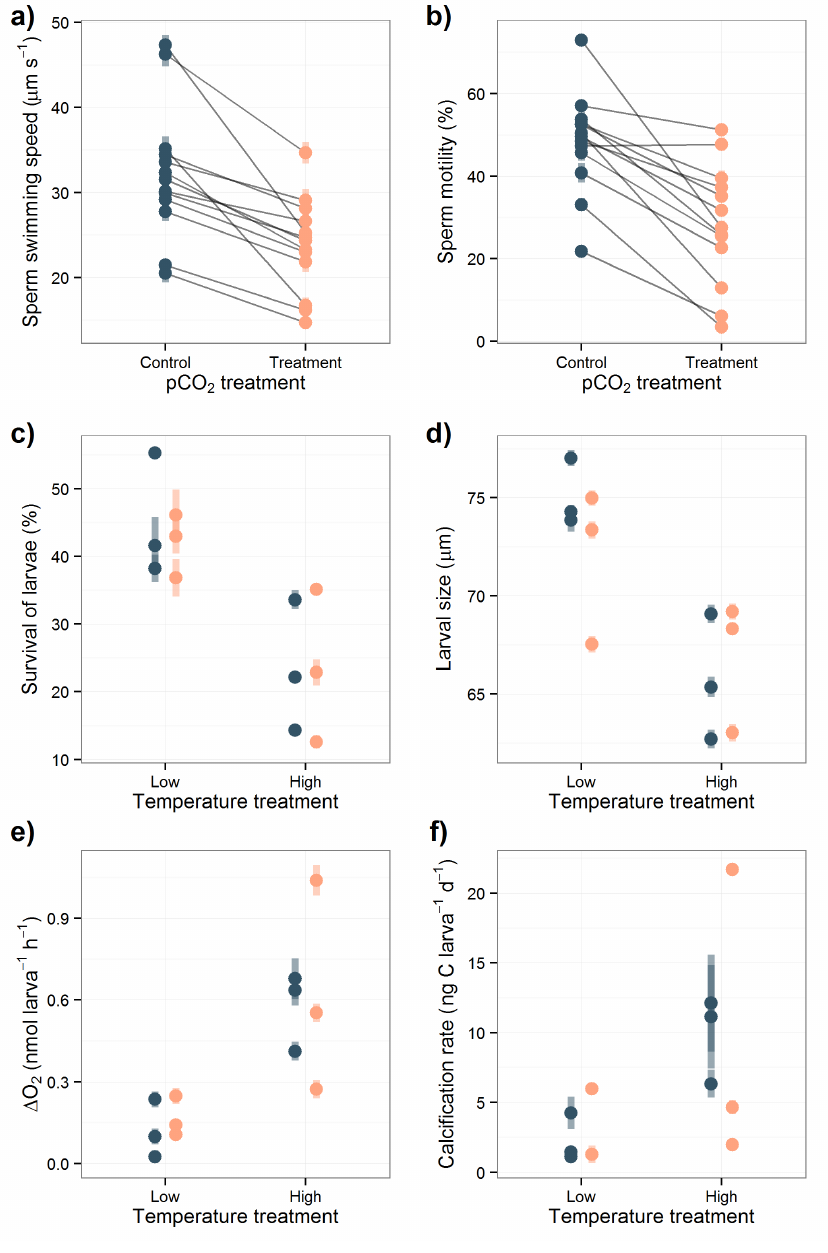
Figure A2. Raw data used for calculating the effect sizes (Figure 3): (a) sperm swimming speed and (b) sperm motility measured at 16 ◦ C. Lines between points mark individuals; (c) survival rate; (d) larval size; (e) respiration and (f) calcification rate of larvae measured in low ( ≈ 17 ◦ C) and high temperature ( ≈ 20 ◦ C) treatments. Dots indicate mean values for replicates ( n = 13 for ( a , b ), 3 for ( c – e ), 2 for low temperature TSW, otherwise 3 in ( f )) and error bars show SE ¯X . Measurements without error bars lack measurement replication in ( f ). Dark blue indicates control p CO treatment, while light orange high p CO 2 2